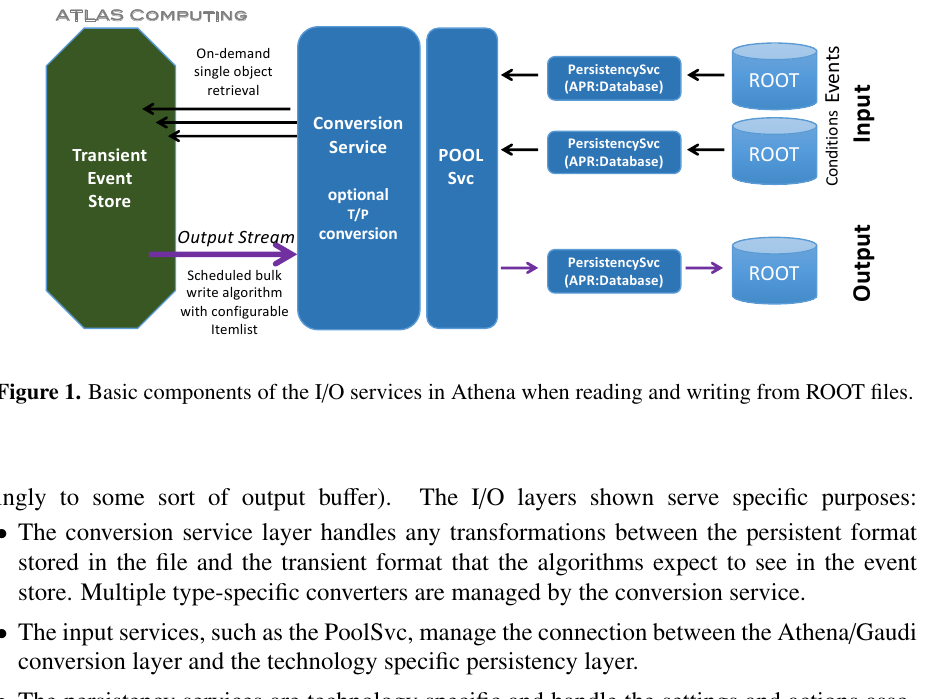
ingly to some sort of output bu ff